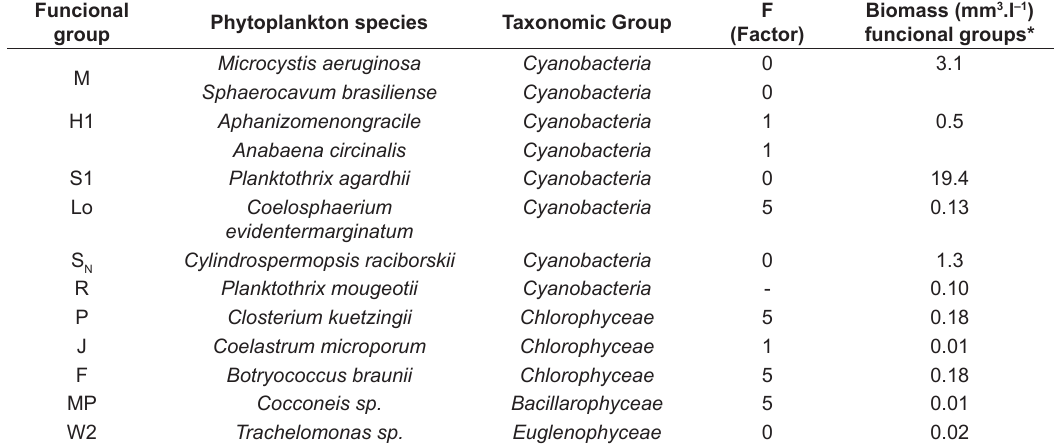
Table 4. Main Phytoplankton species with their taxonomic biomass and functional groups, and respective F for the Armando Ribeiro Gonçalves reservoir between 2009 and